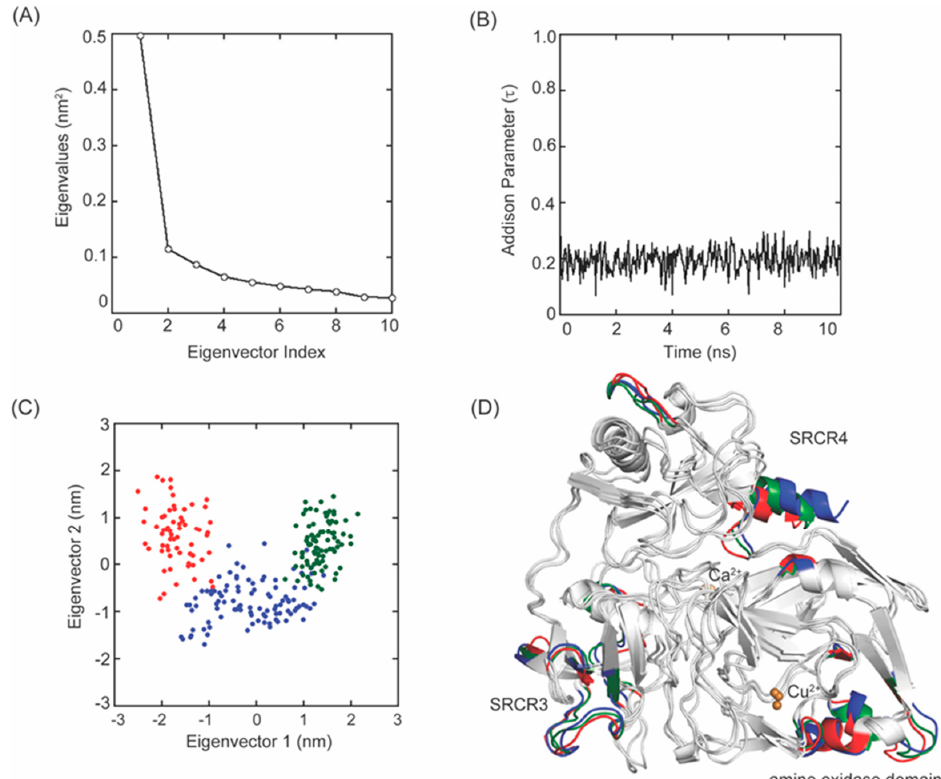
Figure 8. MD − simulation of the 2HP − inhibited Δ 1 − 2SRCR − LOXL2. ( A ) A plot of eigenvalues versus the first 10 eigenvector indices obtained from the covariance matrix of C α atoms over a stable trajectory of 10 ns of MD − simulation. ( B ) A plot of the Addison parameter ( τ ) values of the active site Cu 2+ during 10 s MD − simulation indicates a square pyramidal coordination geometry. ( C ) Projection of the motion of C α atoms of Δ 1 − 2SRCR − LOXL2 along the first two principal eigenvectors during 0–1.08 ns (in red), 1.12–4.96 ns (in blue), and 5–10 ns (in green). ( D ) The C α atoms corresponding to those in ( C ) are highlighted in the same colors.